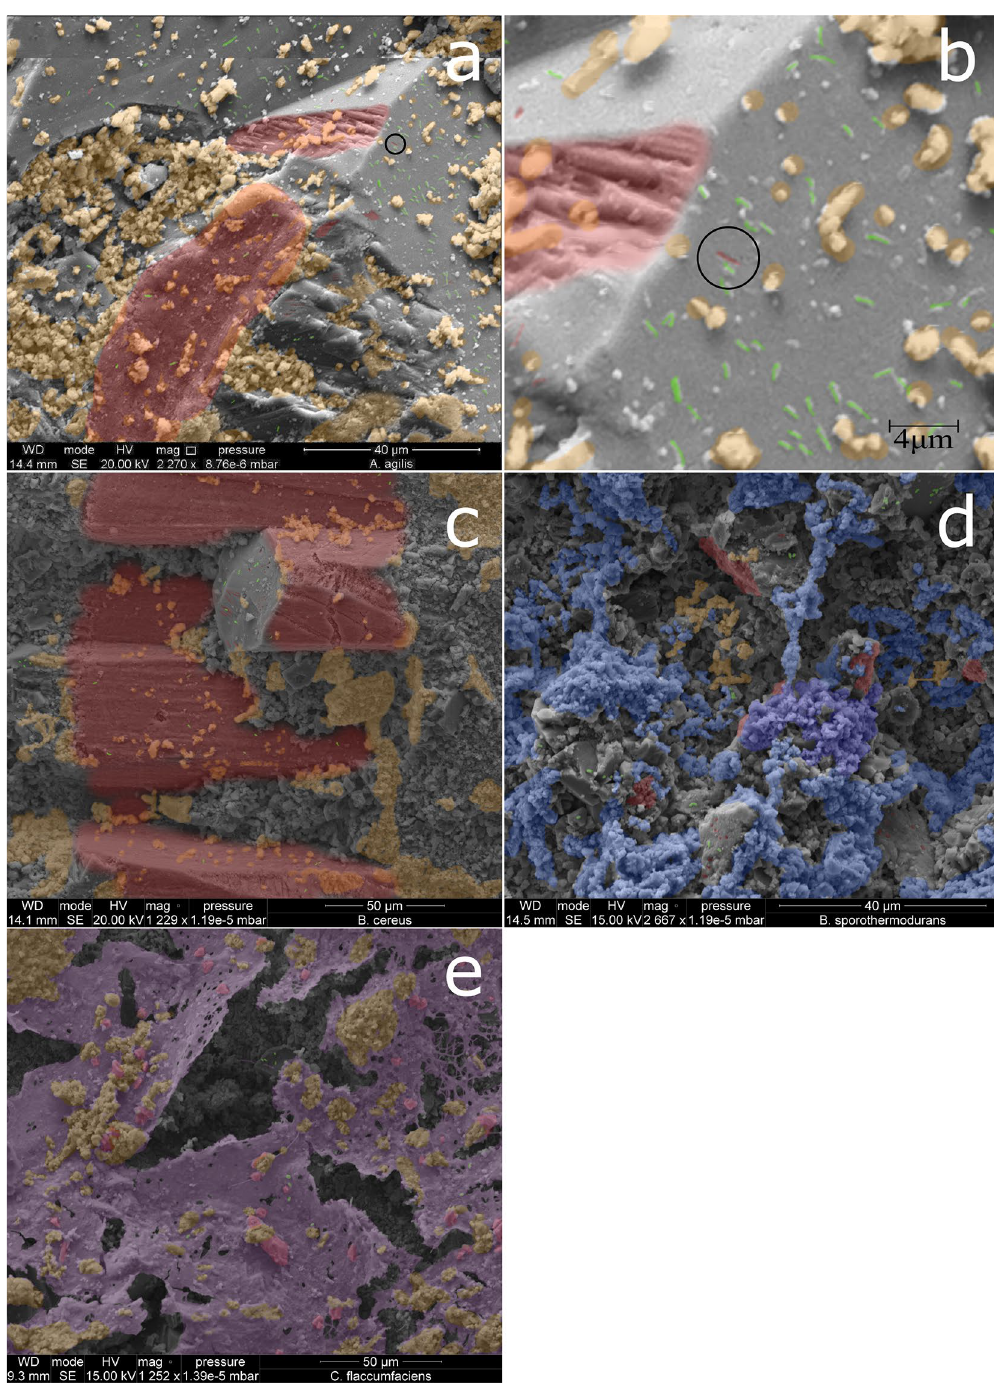
Figure 4. SEM images showing biofilm presence and areas of pitting and etching. Biofilm is shaded orange unless calcified when it is blue or a biofilm sheet when it is violet. Bacterial cells are shaded green when not encapsulated in biofilm matrix. Areas of damage are shaded red. Images ( a , b ) Black ring on Arthrobacter agilis picture highlights a very good example of bacterial pitting. Image b shows an enlarged copy of the area within the ring, the bacterial pit is highlighted in red and is the same dimensions as the surrounding cells, highlighted in green. ( c ) SEM image of Bacillus cereus showing high levels of etching on nailspar crystals, red, the crystal surface is naturally smooth making it easy to identify the pitting (holes in the surface) and etching (long grooves in the surface). Biofilm is shaded orange. Bacterial cells are shaded green when not encapsulated in biofilm matrix. ( d ) Bacillus sporothermodurans demonstrated high levels of calcification of the biofilm matrix, blue. Uncalcified biofilm is shaded orange with pitting and etching shaded red. Bacterial cells are shaded green when not encapsulated in biofilm matrix. ( e ) Curtobacterium flaccumfaciens produced two forms of biofilm matrix, sheets and clusters. The sheets showed evidence of physical damage caused by the biofilm matrix, shaded purple, growing through the limestone oolitic matrix and lifting the smaller oolites, shaded red, from the surface. Where the biofilm formed in clusters it is shaded orange, bacterial cells are shaded green when not encapsulated in biofilm